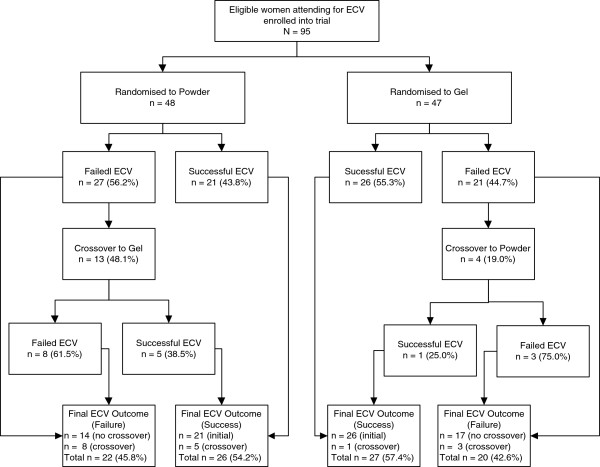
Recruitment flow chart for a randomised trial of talcum powder versus aqueous gel for external cephalic version.